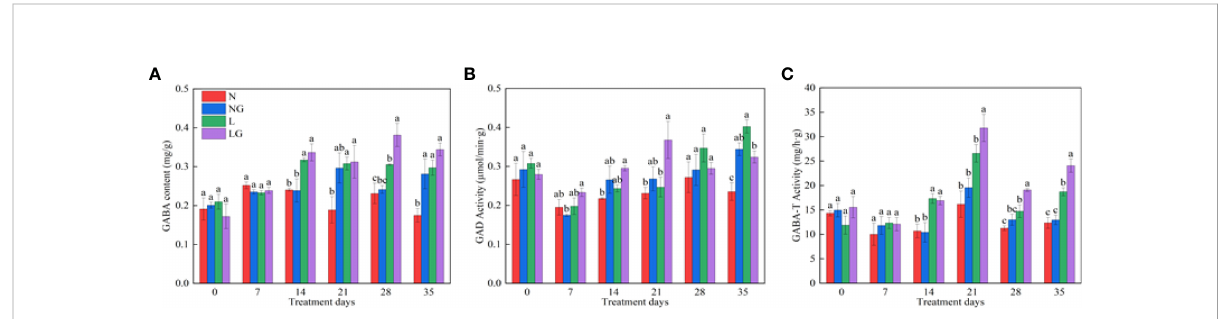
FIGURE 8 Effects of GABA spraying on the endogenous GABA metabolism of seedlings on different treatment days. (A) The endogenous g -aminobutyric acid (GABA) content in leaves; (B) glutamic acid decarboxylase (GAD) activity in leaves; (C) aminobutyrate transaminase (GABA-T) activity in leaves. N, the plant pretreated with distilled water and grown at normal temperature. NG, the plant pretreated with GABA and grown at normal temperature. L, the plant pretreated with distilled water and grown at low-temperature. LG, the plant pretreated with GABA and grown at low-